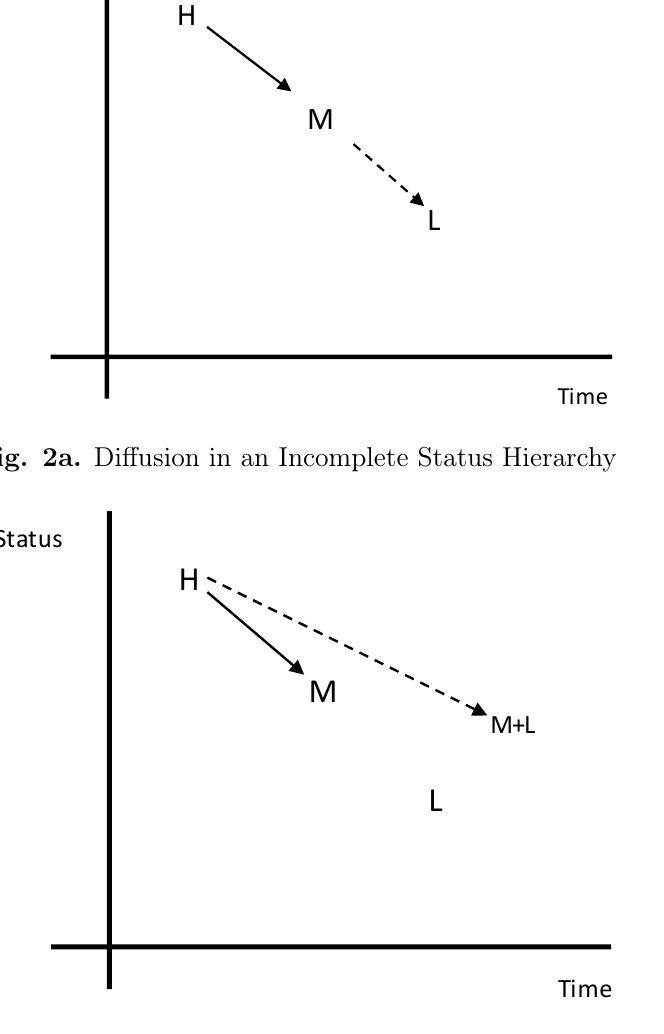
Fig. 2b. Diffusion in a Compound Status